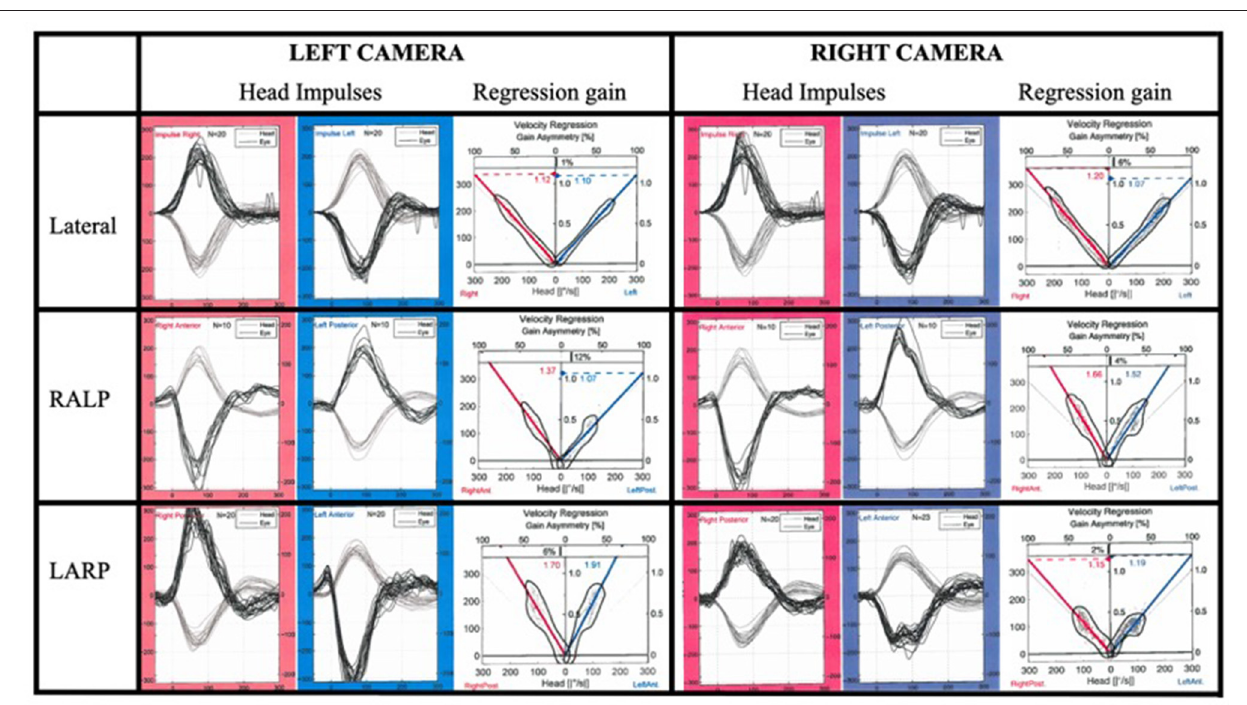
FIGURE 4 | The generated eye and head velocities from one subject with all canal HITs recorded simultaneously by two devices positioned above different